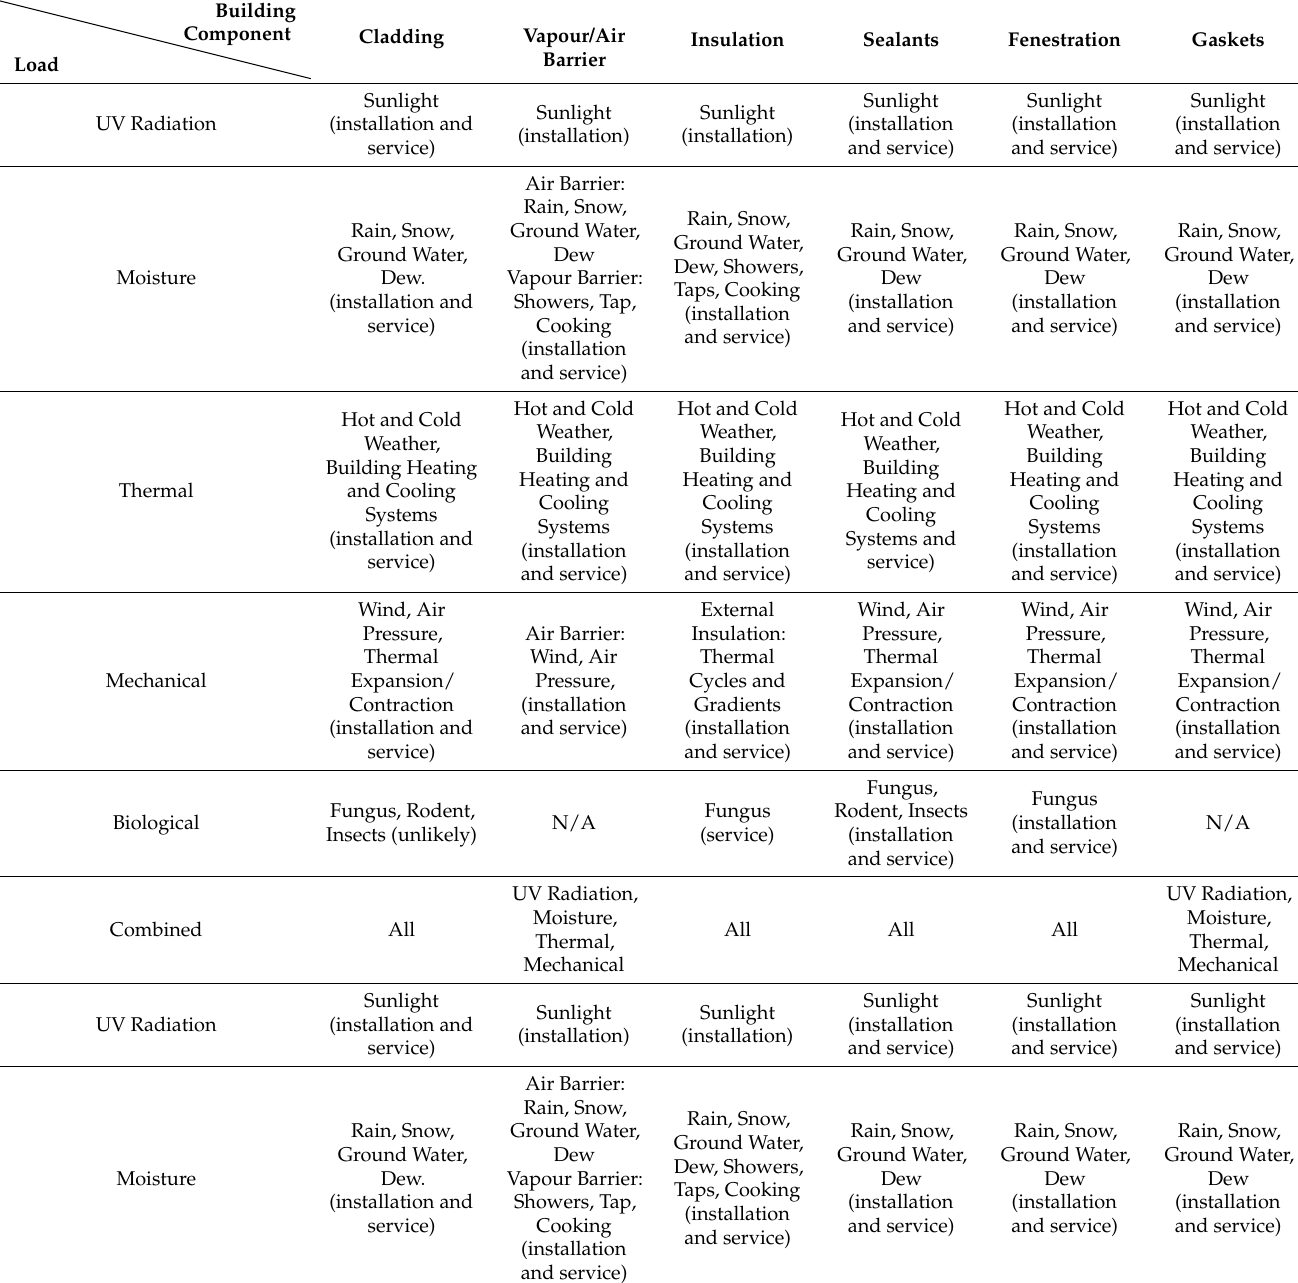
Table 3. Environmental loads that apply to polymeric building envelope